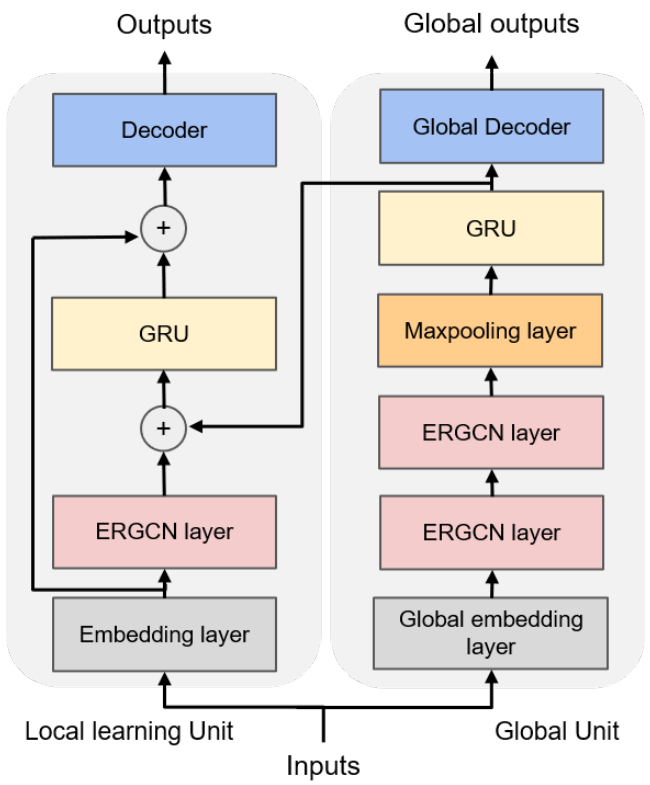
Figure 2. Main structure of